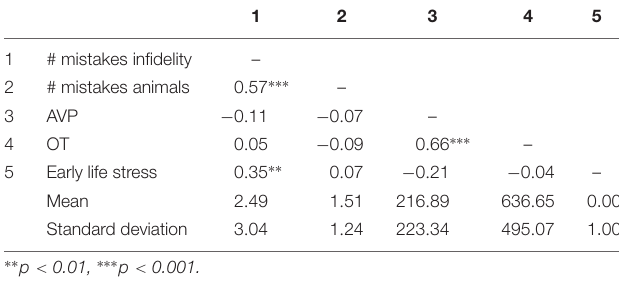
TABLE 2 | Pattern of associations between main study measures as well as means and standard deviations (Study 1).